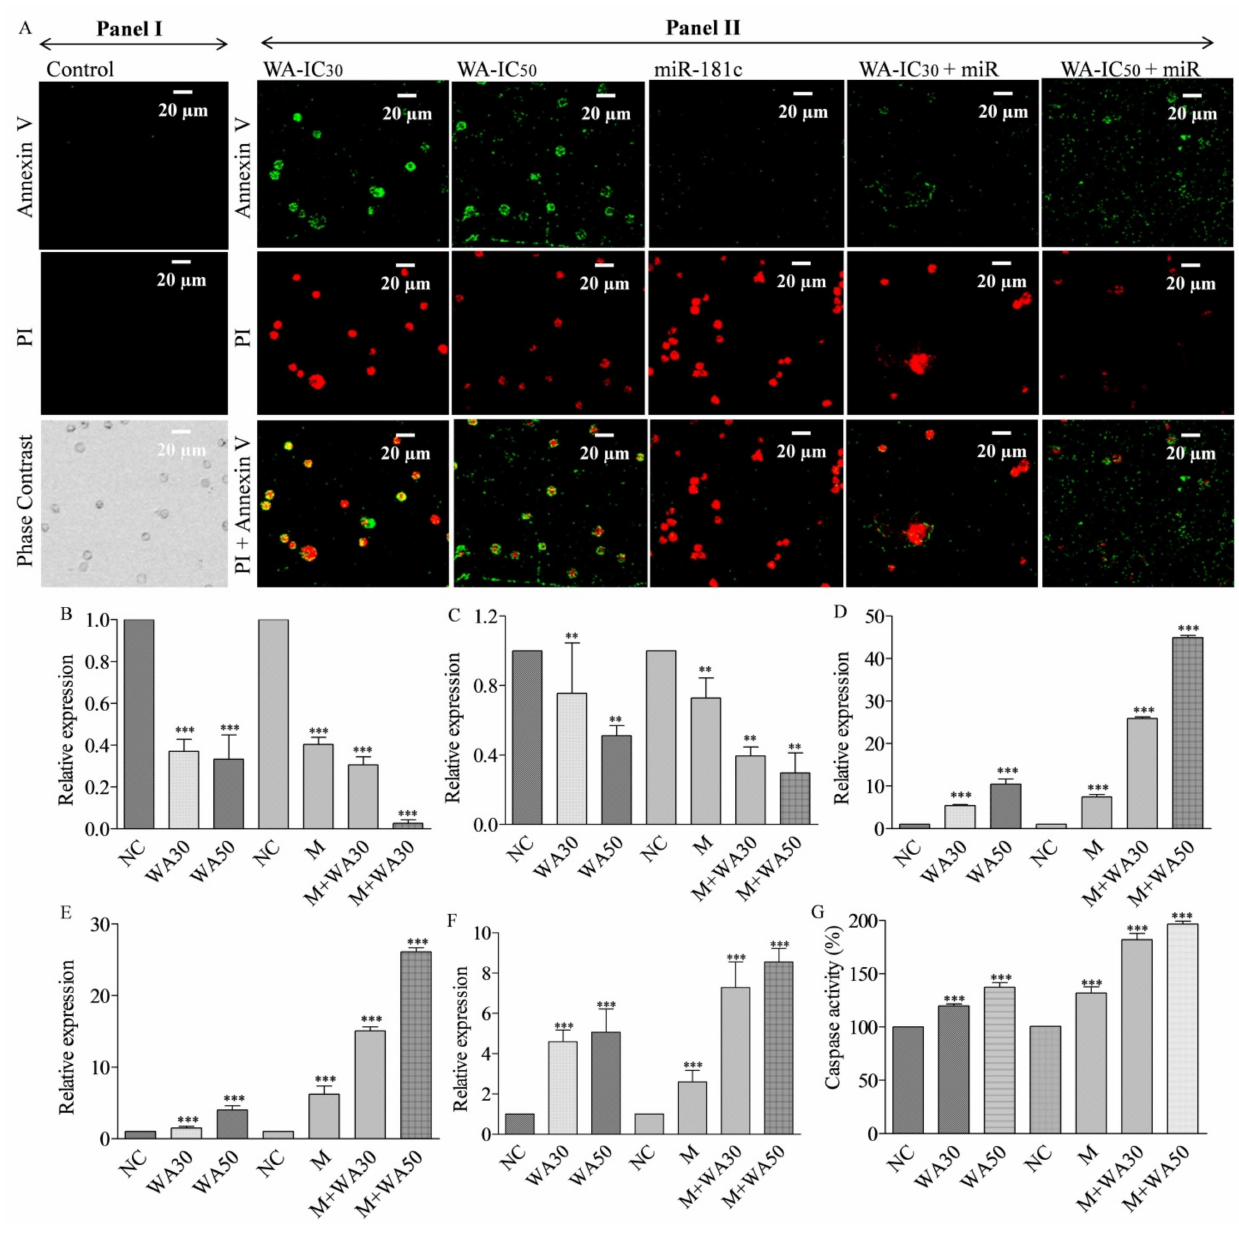
Figure 6. The effect of Withaferin A and mi-181c-5p mimic co-treatment on the apoptotic cell population, apoptosis-related marker expression, and caspase enzymatic activity in TNBC cells. ( A ) Panel I: Apoptosis event in miR-181c-5p mimic negative control transfected MDA-MB-231 cells detected by annexin V and PI. Panel II: Apoptosis induction in Withaferin A (IC 30 and IC 50 ), miR-181c- 5p mimic and their co-treatment in MDA-MB-231 cells in 24 h exposure. qRT-PCR based expression analysis of apoptosis-related markers. ( B ) PARP, ( C ) BCL-XL, ( D ) Caspase 3, ( E ) Caspase 8 ( F ),